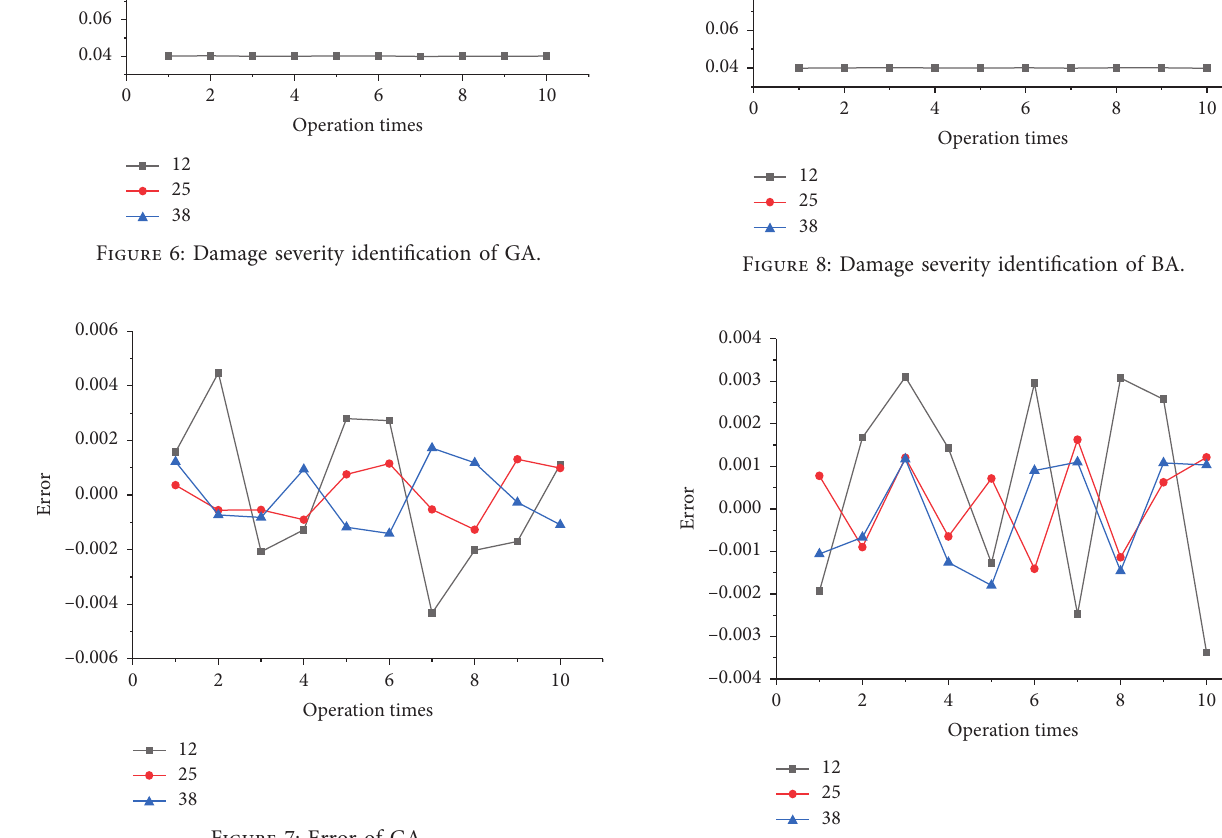
Figure 7: Error of GA.